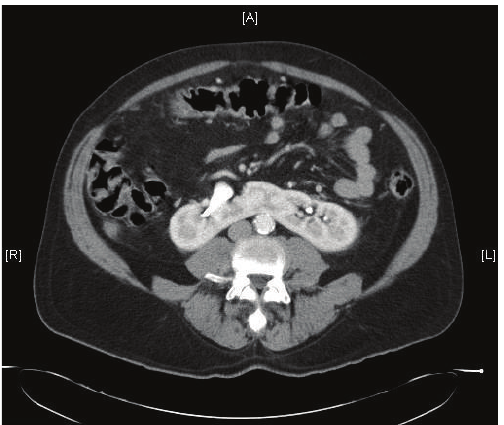
Figure 3: Donor CT scan. This image from the prerecovery donor CT scan shows the bridge of the horseshoe kidney and the inferior most portion of the collecting system noted on CT